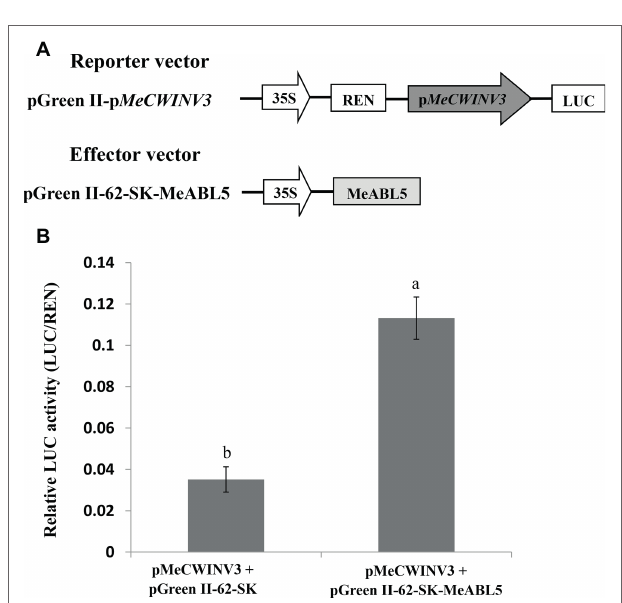
FIGURE 8 | Regulation of the transcription activity of the MeCWINV3 promoter by MeABL5 in a transient expression system. (A) Schematic diagrams of the vectors used in the transient expression analysis. (B) Transcriptional activity assay of the MeCWINV3 promoter coinfiltrated with the effector vectors pGreen II 62-SK (control) or pGreen II 62-SK-MeABL5 into tobacco leaves. The MeCWINV3 promoter was fused to the LUC reporter and the promoter activity was determined by a transient dual-LUC assay. The relative LUC activities were normalized to the reference Renilla (REN) luciferase. Error bars represent the SD of nine technical replicates. The significant difference was assessed by ANOVA; a and b represent a significant difference at p < 0.01.